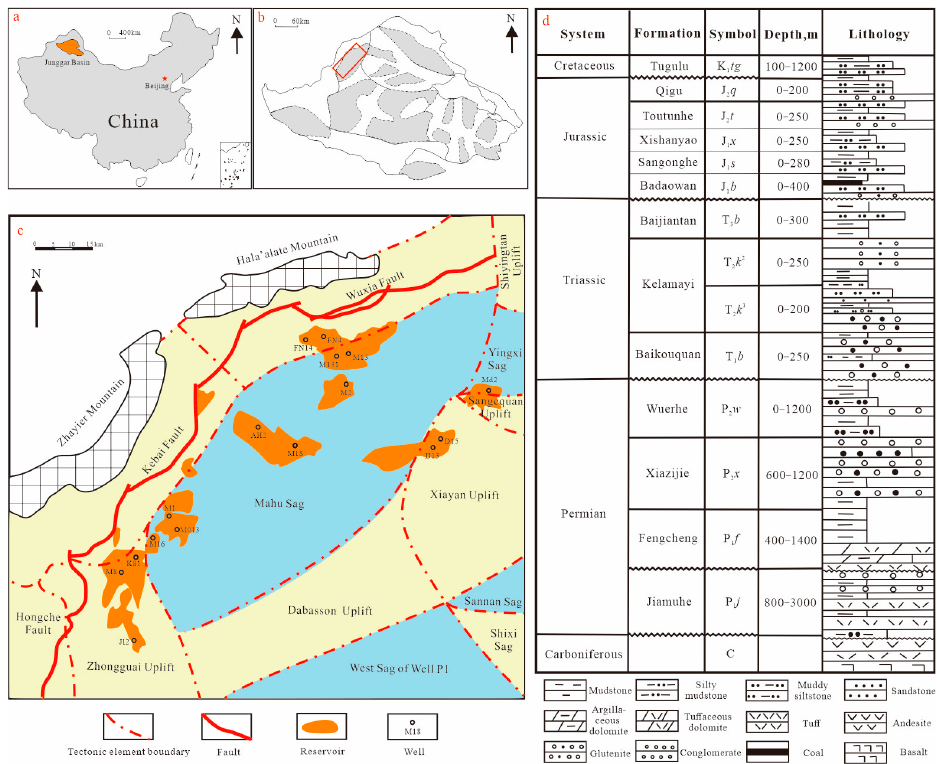
Figure 1. ( a ) Location of the Junggar Basin; ( b ) Location of Mahu Sag; ( c ) Geological and structural map of Mahu Sag; ( d ) Stratigraphic lithology histogram of Mahu Sag [41] .